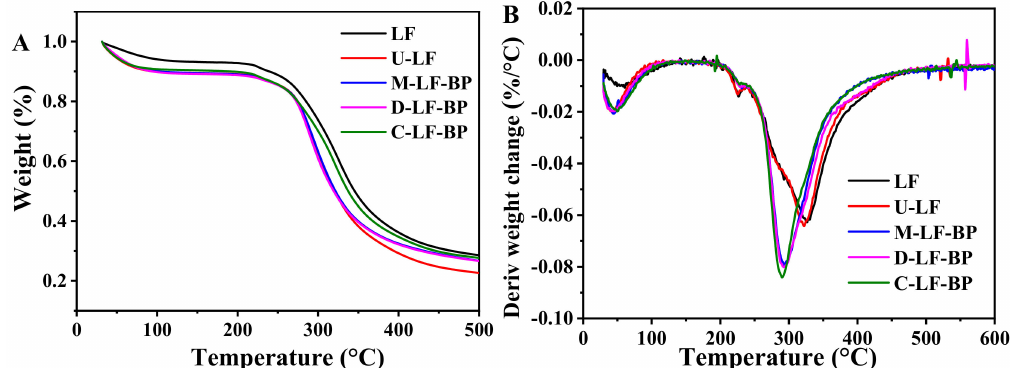
Figure 4. ( A ) Weight and ( B ) deriv weight change of LF, U-LF, M-LF-BP, D-LF-BP and